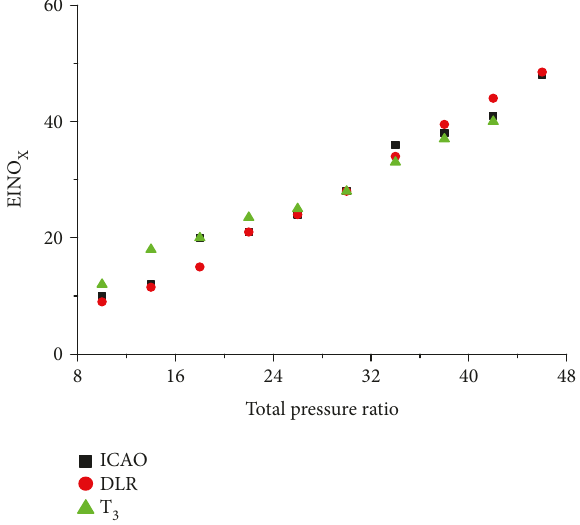
on emission prediction. f